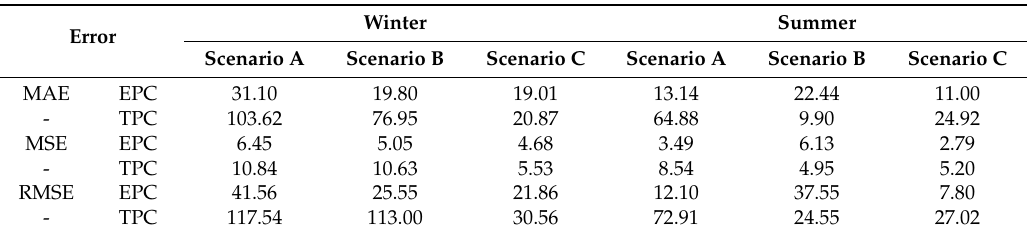
Table 4. Statistical performance of the effective power curve.